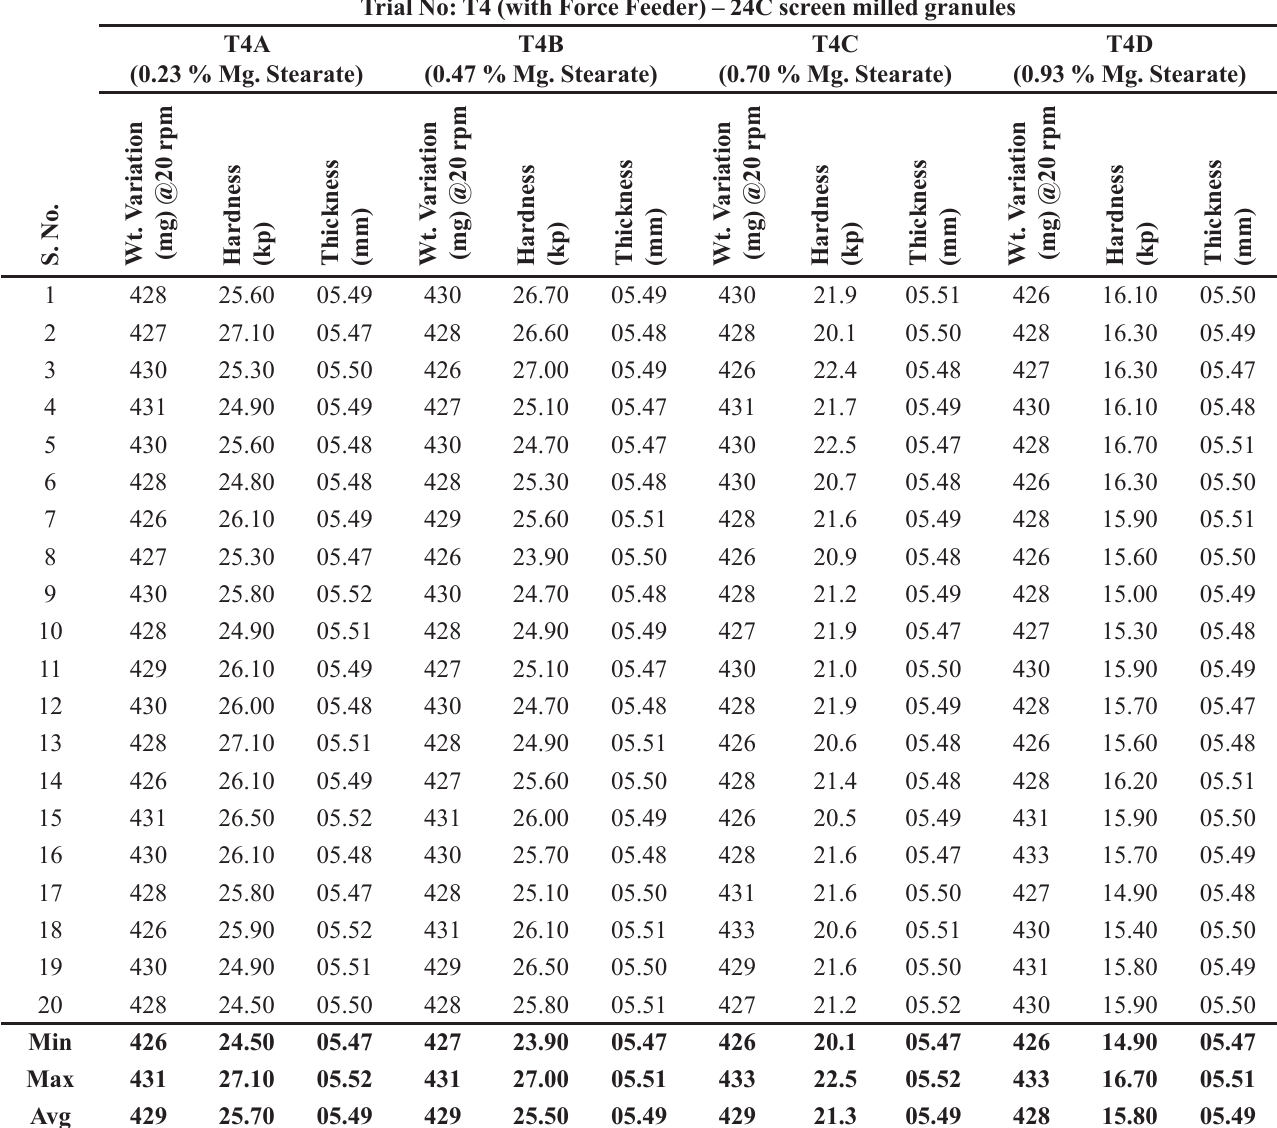
TABLE VII - Compression data for trial no T4A, T4B, T4C & T4D (using force feeder) of 24C screen milled granules Trial No: T4 (with Force Feeder) – 24C screen milled